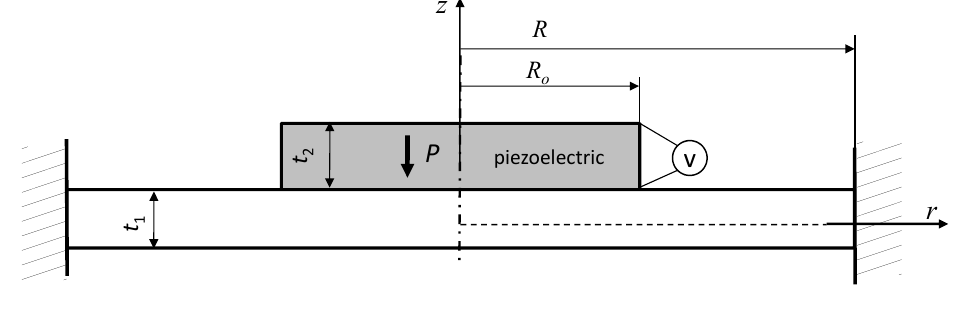
Figure 3. The unimorph actuator.